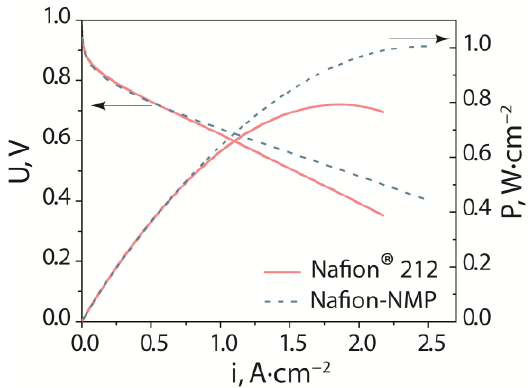
Figure 4. Temperature dependence of proton conductivity of Nafion ® 212 and Nafion-NMP mem- branes in contact with water.